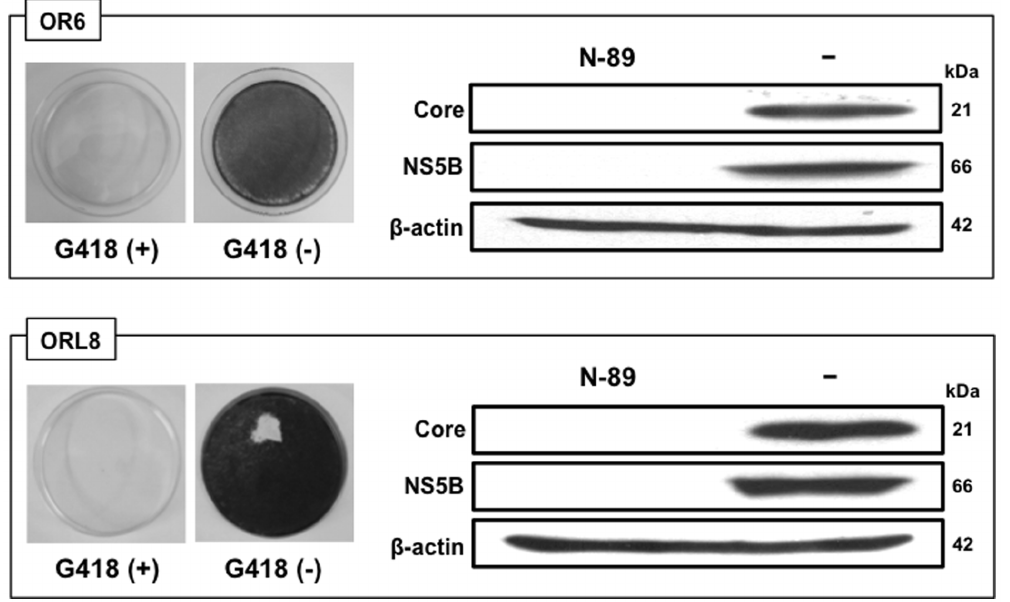
Figure 3. OR6 and ORL8 cells were cured by treatment with only N-89. The treated cells were divided into two plates with or without G418, and then cultured for 2 weeks. The left panels show the cells stained with Coomassie brilliant blue. The right panels show the results of Western blot analysis of the treated and non-treated cells for HCV proteins. Western blot analysis was performed as described in Fig. 1B.